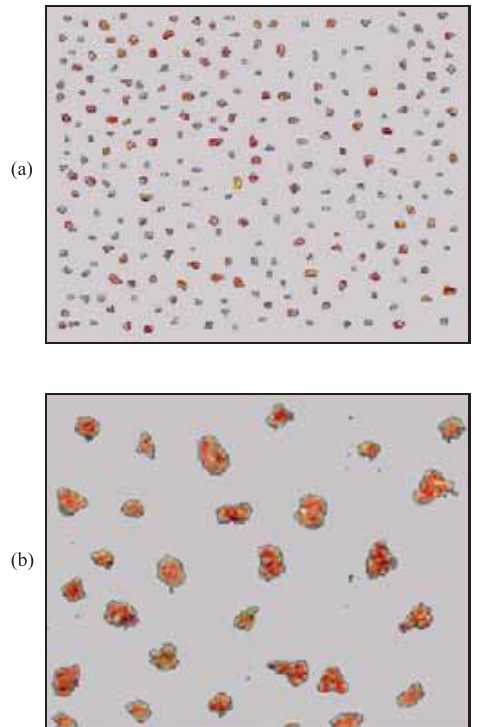
Figura 1. Imagem obtida no scanner dos agregados da classe de tamanho de 1 a 2 mm do horizonte Bw2 do perfil 3 do Latossolo Bruno. (a) imagem original; e (b) imagem ampliada ( zoom ), mostrando as diferentes morfologias dos agregados.